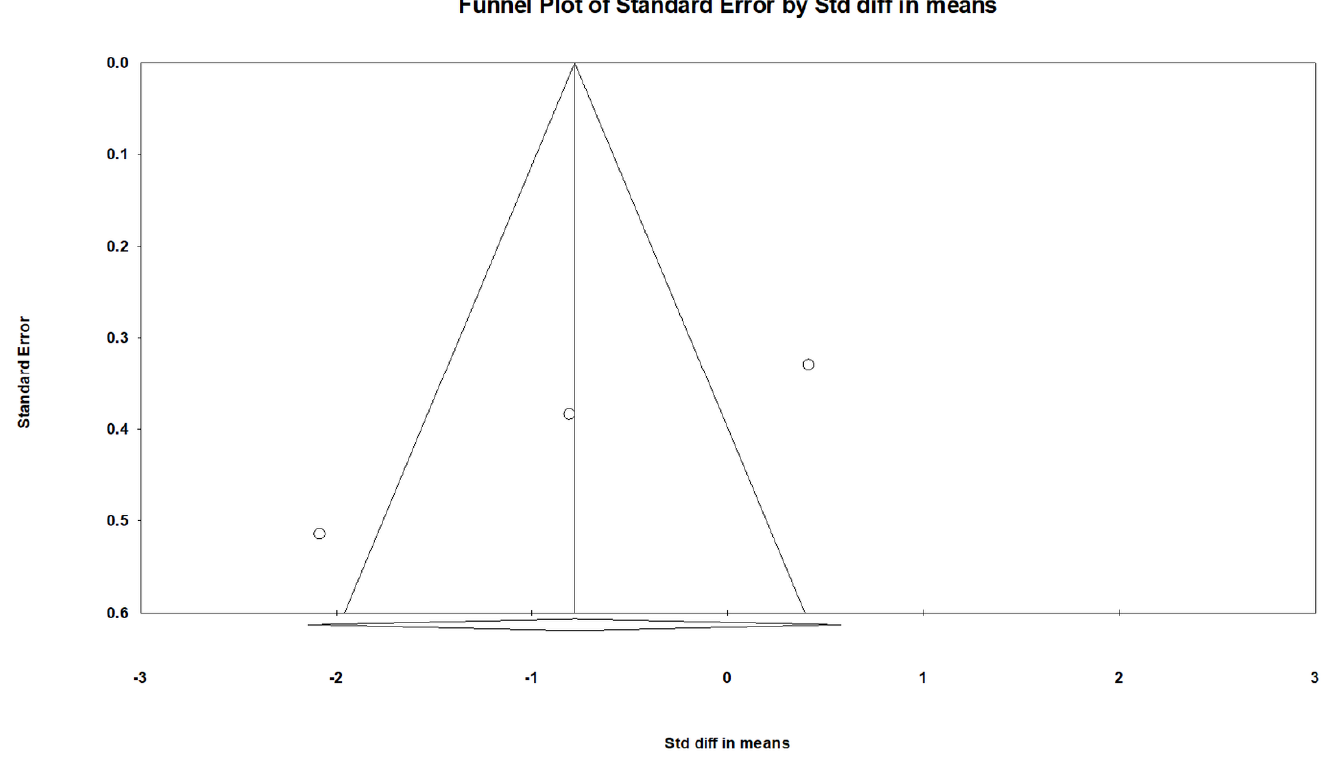
Figure 5. Funnel plot of the included articles. The summarized effect size was showed by the diamond, and each dot indicates a single study.